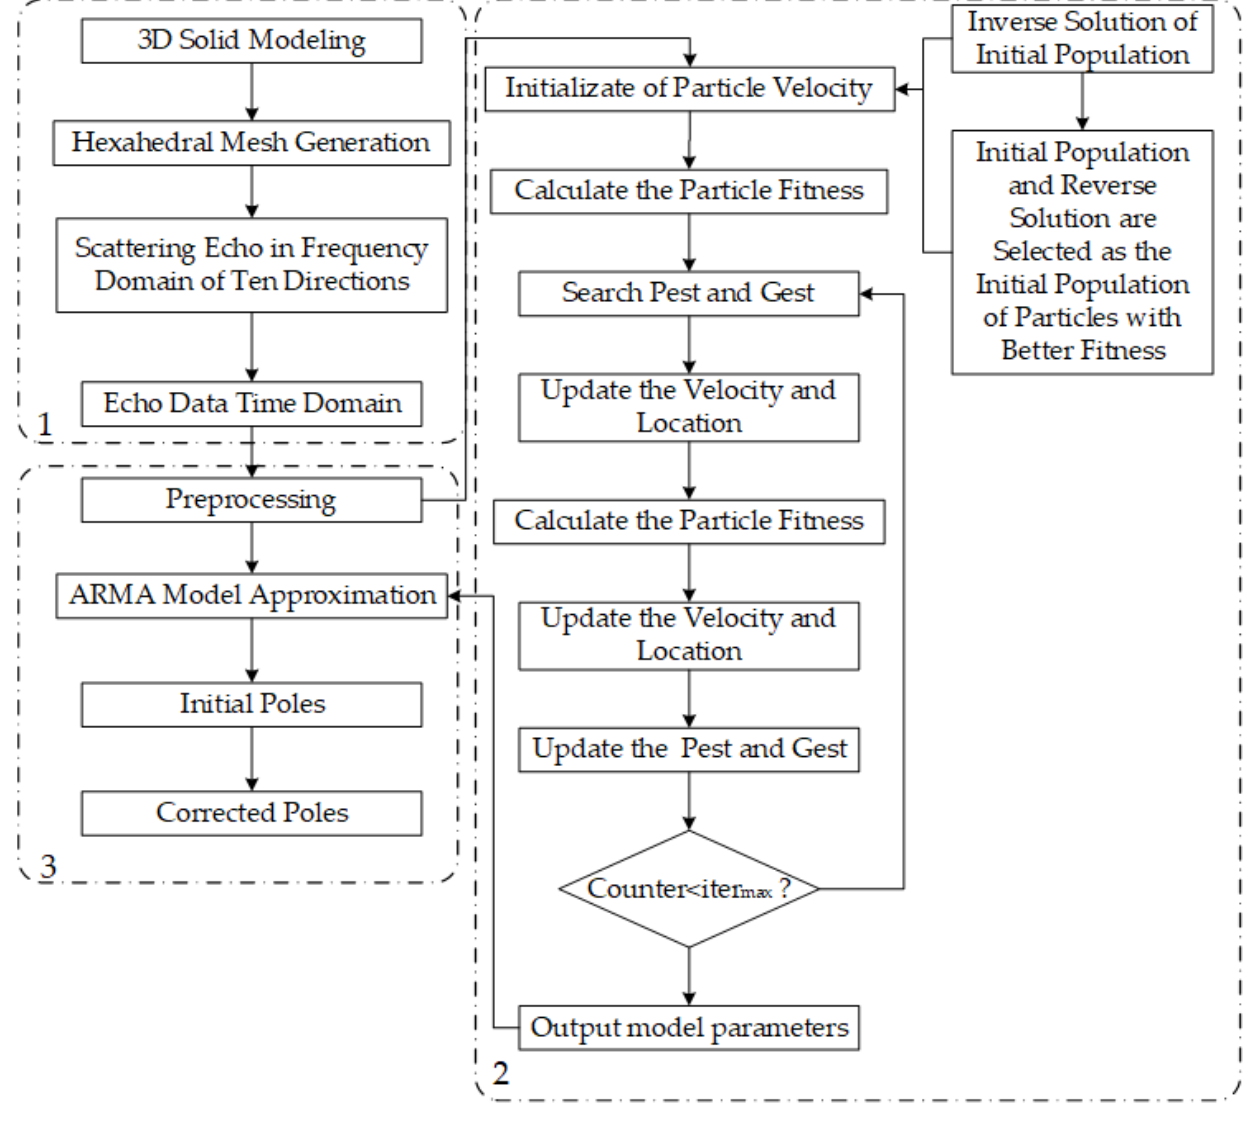
Figure 1. Main experimental process of poles extraction.